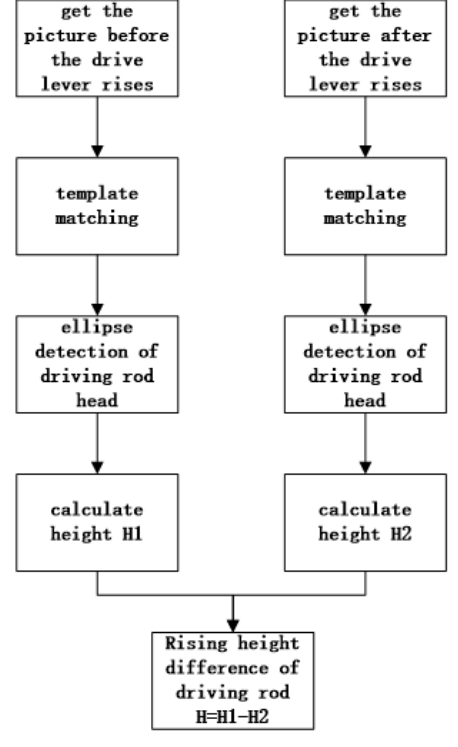
Figure 2. Driving-rod-detection flow